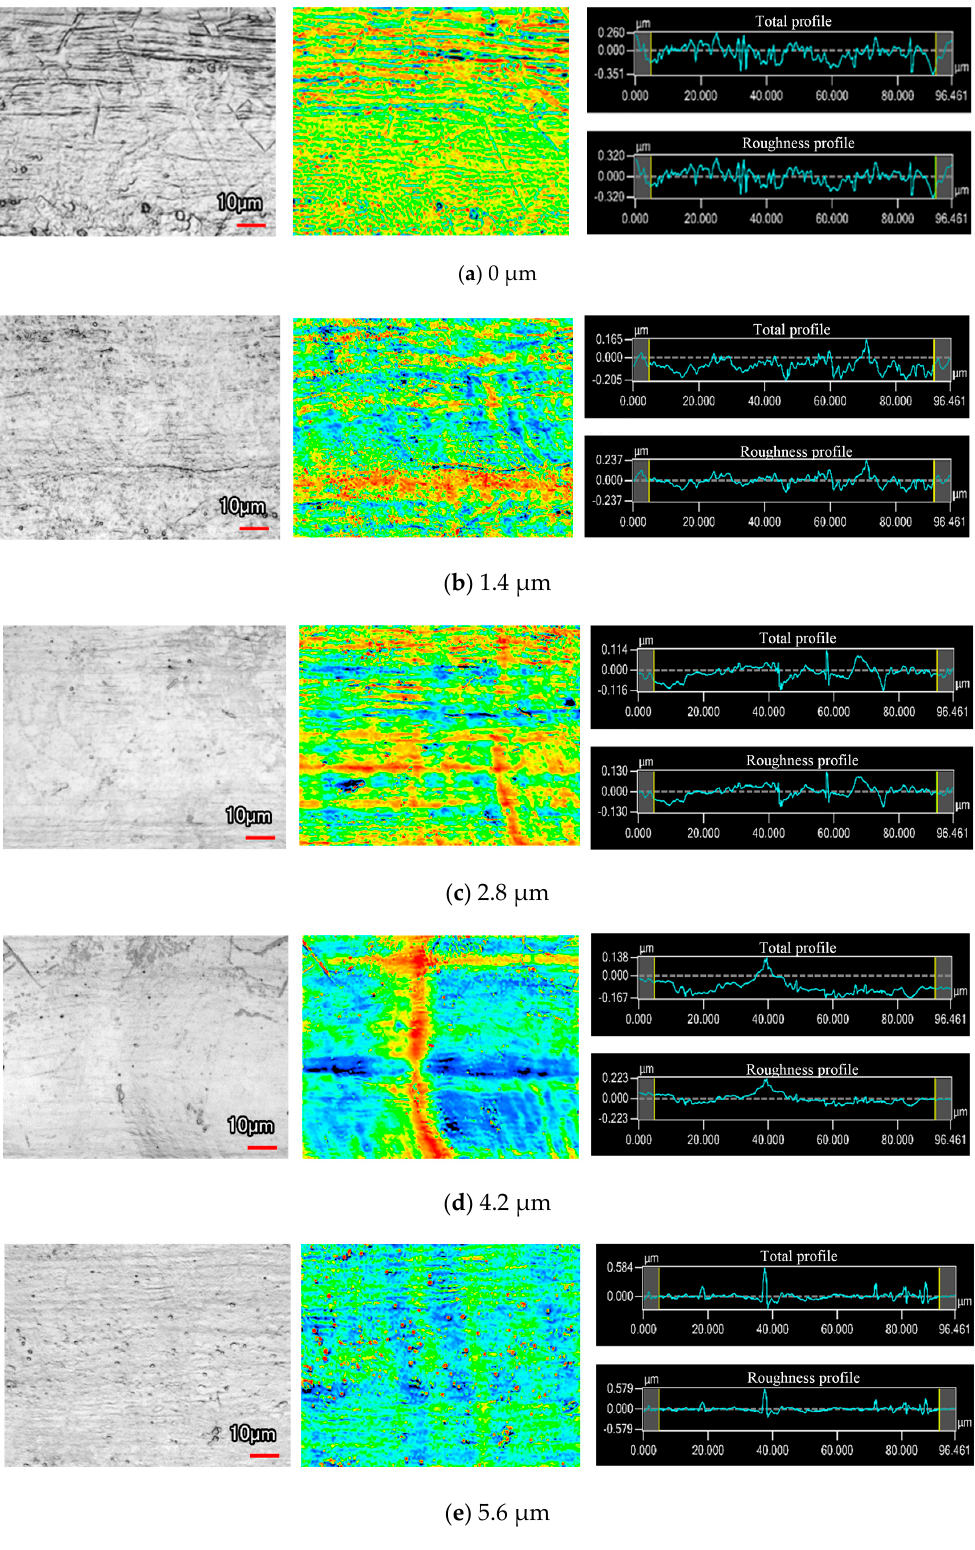
Figure 10. Surface morphology under di ff erent vibration